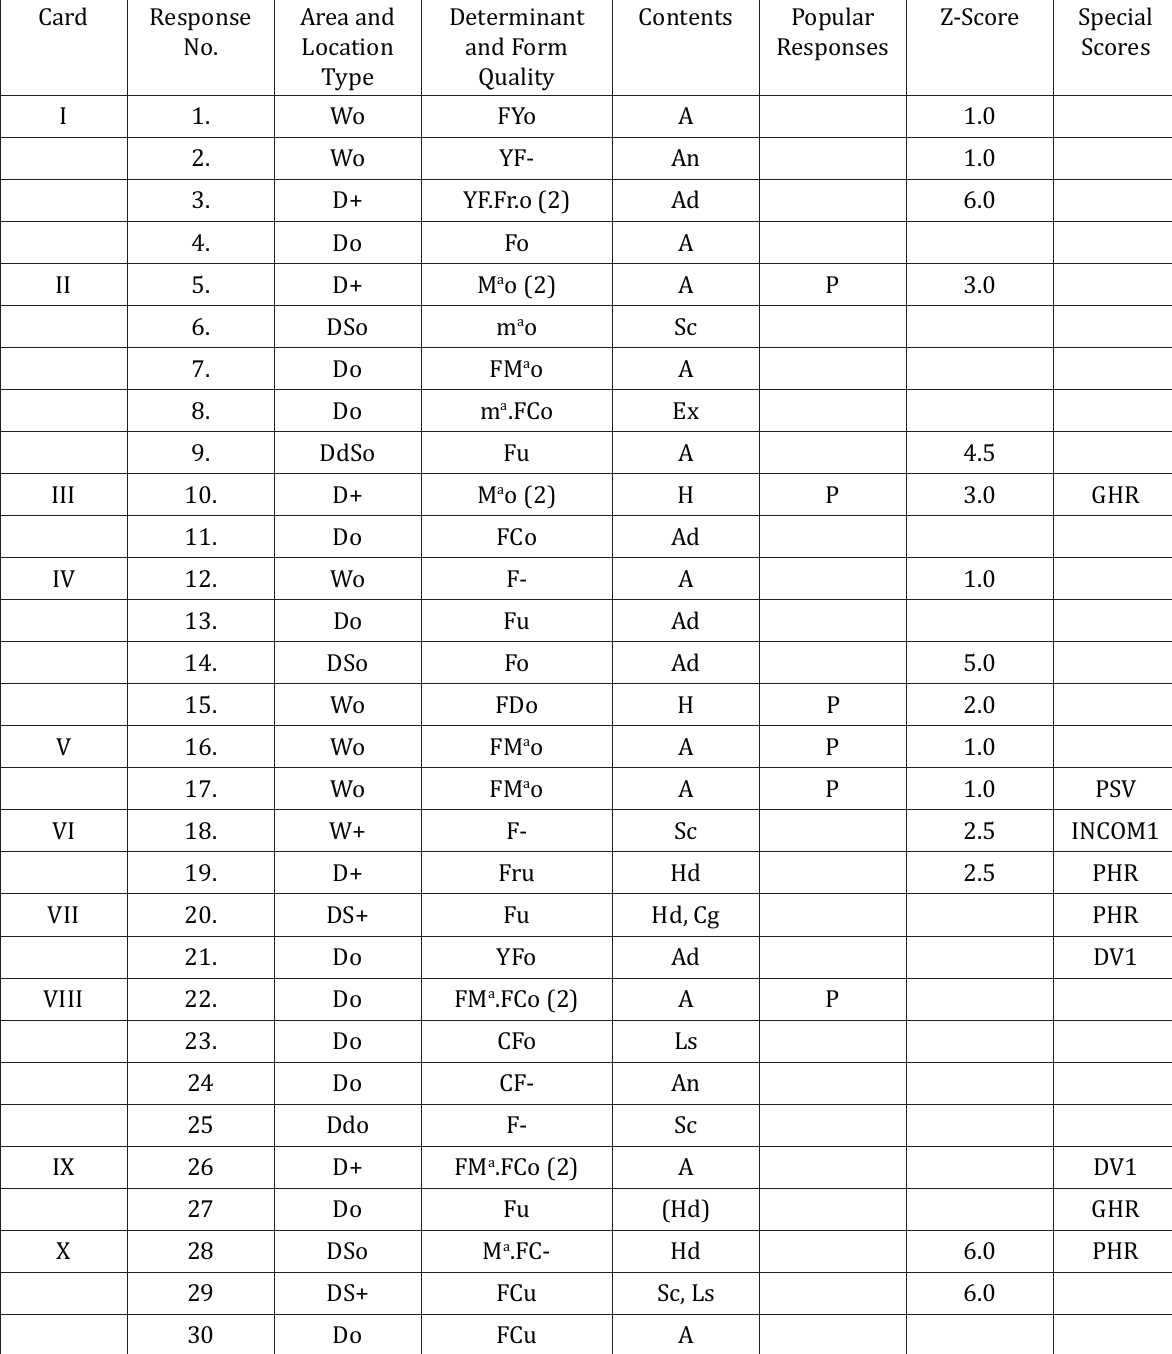
Table 1. Sequence of